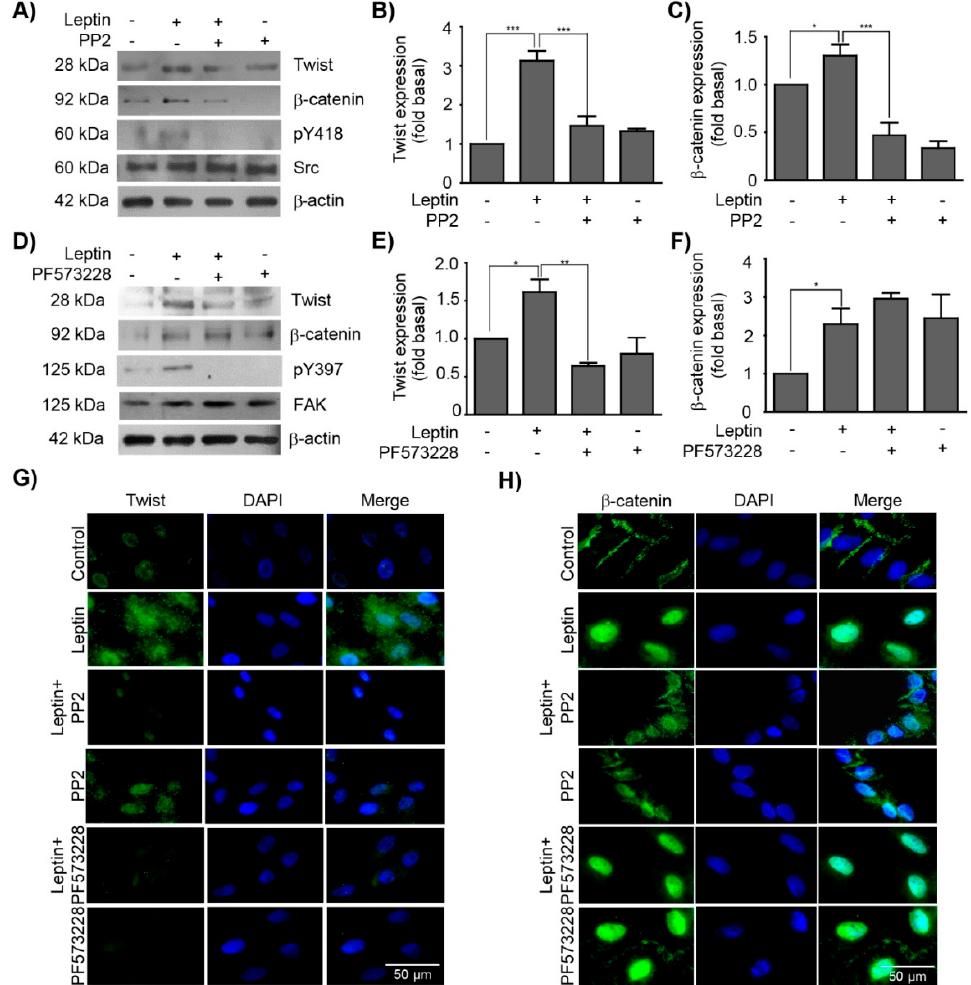
Figure 3. Src and FAK regulate the expression and subcellular localization of Twist and β -catenin. MCF10A cells were pre-treated with Src (PP2) or FAK (PF-573228) inhibitors, and subsequently with 400 ng / mL of leptin. ( A ) Representative western blots of Twist and β -catenin expression upon Src inhibition. Densitometric analyses of ( B ) Twist and ( C ) β -catenin expression upon Src inhibition. ( D ) Representative western blots of Twist and β -catenin expression upon FAK inhibition. Densitometric analyses of ( E ) Twist and ( F ) β -catenin expression upon FAK inhibition. β -actin was used as a loading control. The values represent the mean ± SD of three independent experiments and are expressed as changes with respect to the control (unstimulated cells). The asterisks indicate the comparison made with respect to the control. * p < 0.05 and *** p < 0.001 by one-way ANOVA (Newman–Keuls’s test). Representative images of epifluorescence microscopy using a 40 × magnification. MCF10A cells were pre-treated with PP2 and PF-573228 and subsequently stimulated with leptin (400 ng / mL). The subcellular localization of ( G ) Twist and ( H ) β -catenin is shown in green, and in blue the DNA was counterstained with